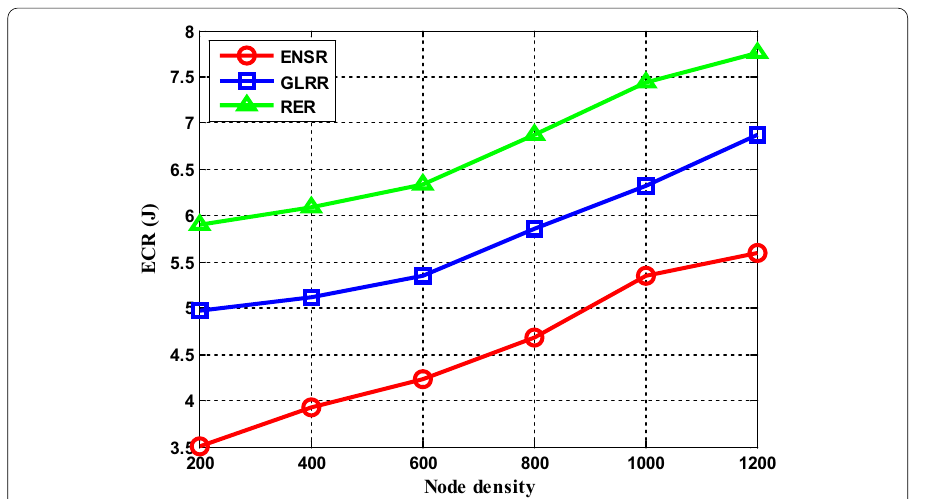
Fig. 11 ECR under different node density